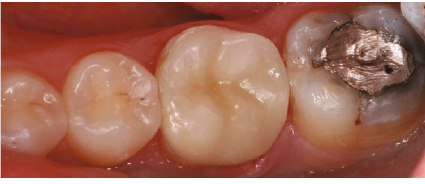
Figure 7: Milled onlay.